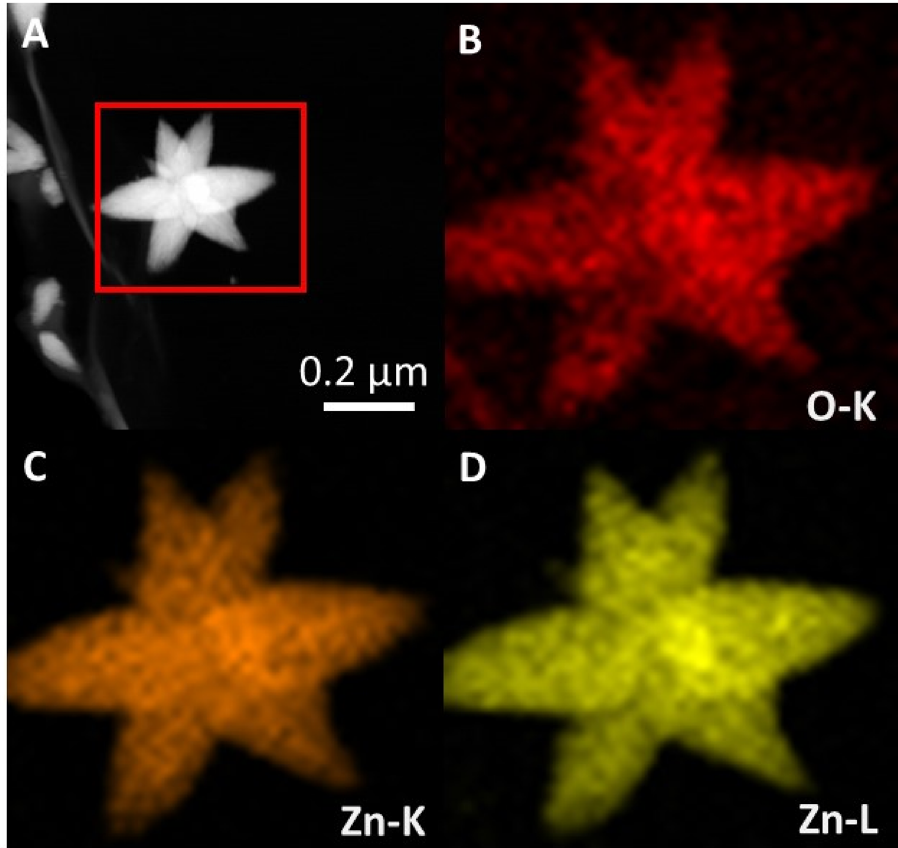
Figure 3. STEM images of the ZnO star ( A ) with corresponding elemental maps of characteristic X-ray: O K-line ( B ), Zn K-line ( C ) and Zn L-line ( D ). EDX maps were acquired from the region marked by a red